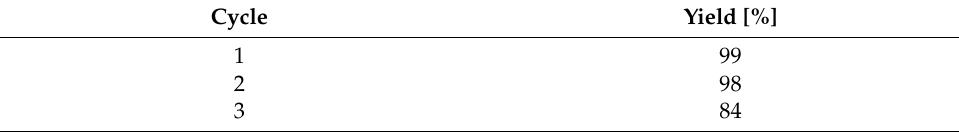
Table 4. The recycling of the catalytic DKR